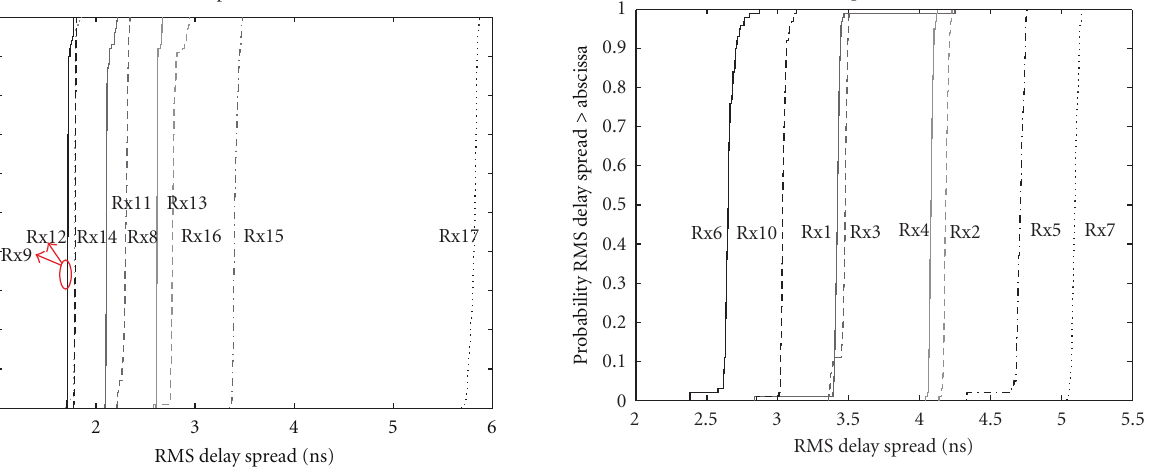
Figure 10: CDFs of the measured RMS delay spreads for LOS in the UWB band measurements.